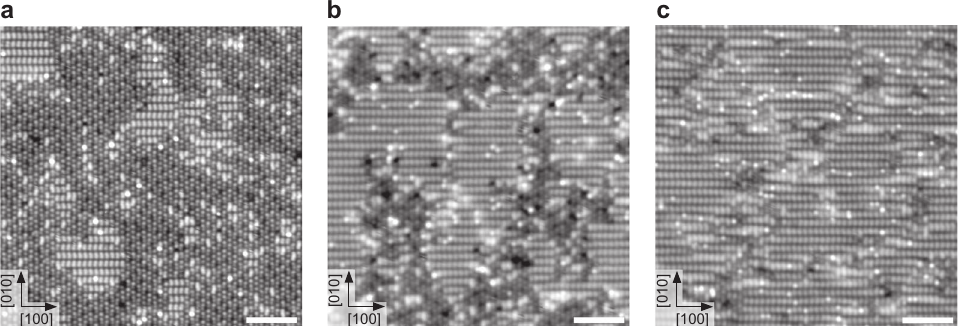
Fig. 6 Effect of increasing water coverage. STM images after exposing the c(2 × 6) OH overlayer to increasing water doses at 105 K and decreasing annealing times at room temperature. a 0.15 L and 1 h annealing time. b 0.5 L and 30 min annealing time. c 1.0 L and 15 min annealing time. The higher the overall water coverage, the more surface is covered by the (1 × 3) OH overlayer. In panel c it covers almost the whole surface. STM parameters: